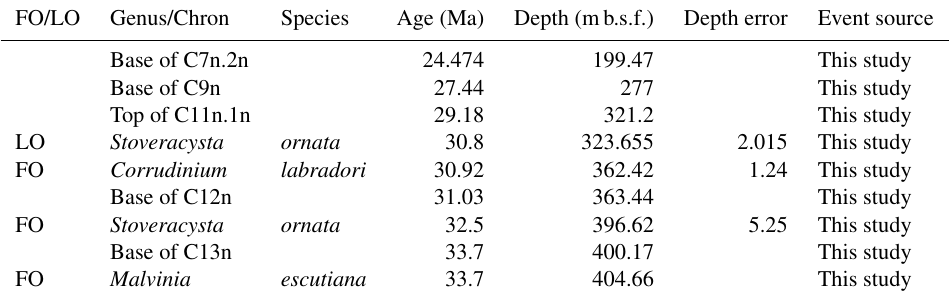
Table 2. Improved age model for the Oligocene of DSDP Site 274 determined by dinocysts biostratigraphy indicators (FO denotes first occurrence, and LO denotes last occurrence) and palaeomagnetic reversals